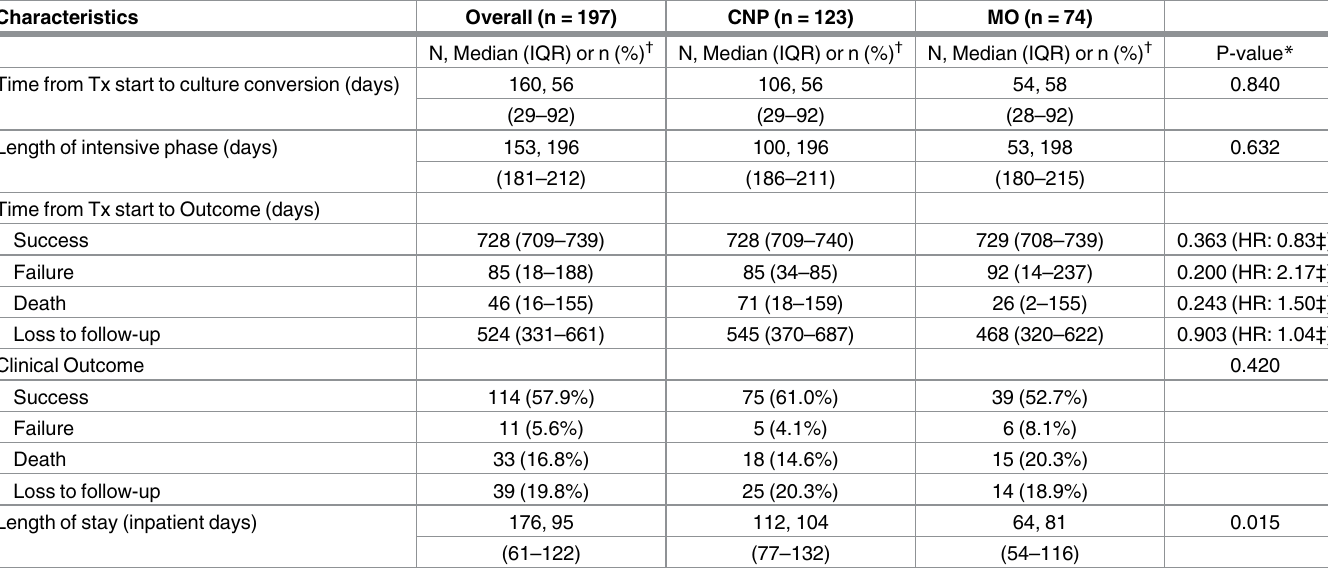
Table 2. Patient outcome data by provider type.